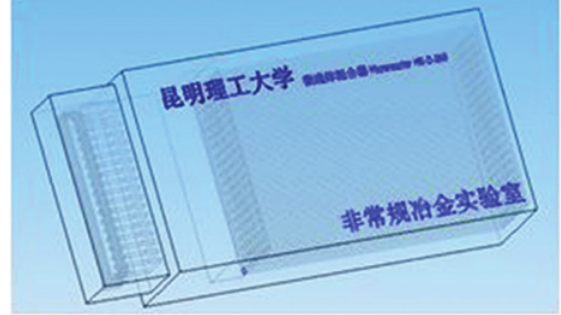
Figure 12: A microfluidic model with 200